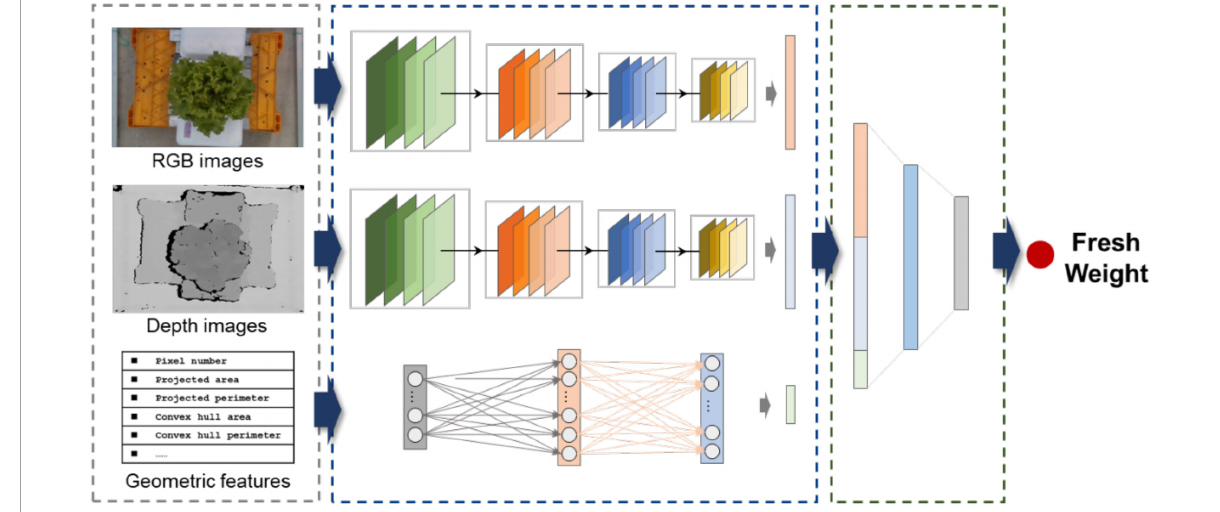
FIGURE3 Overall structure of the multi-branch regression network.